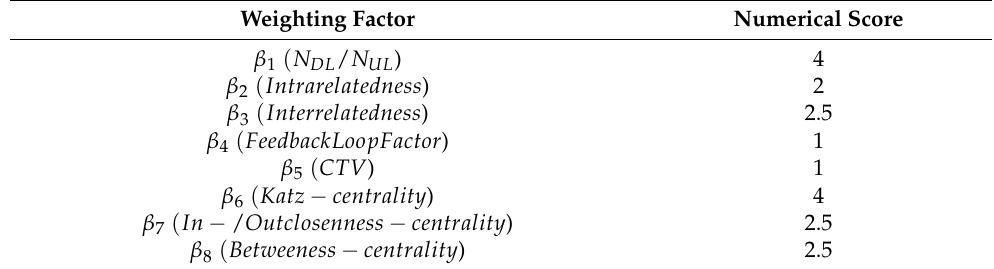
Table 3. Allocation of numerical values of the weighting factors for the calculation of WaU and WaD